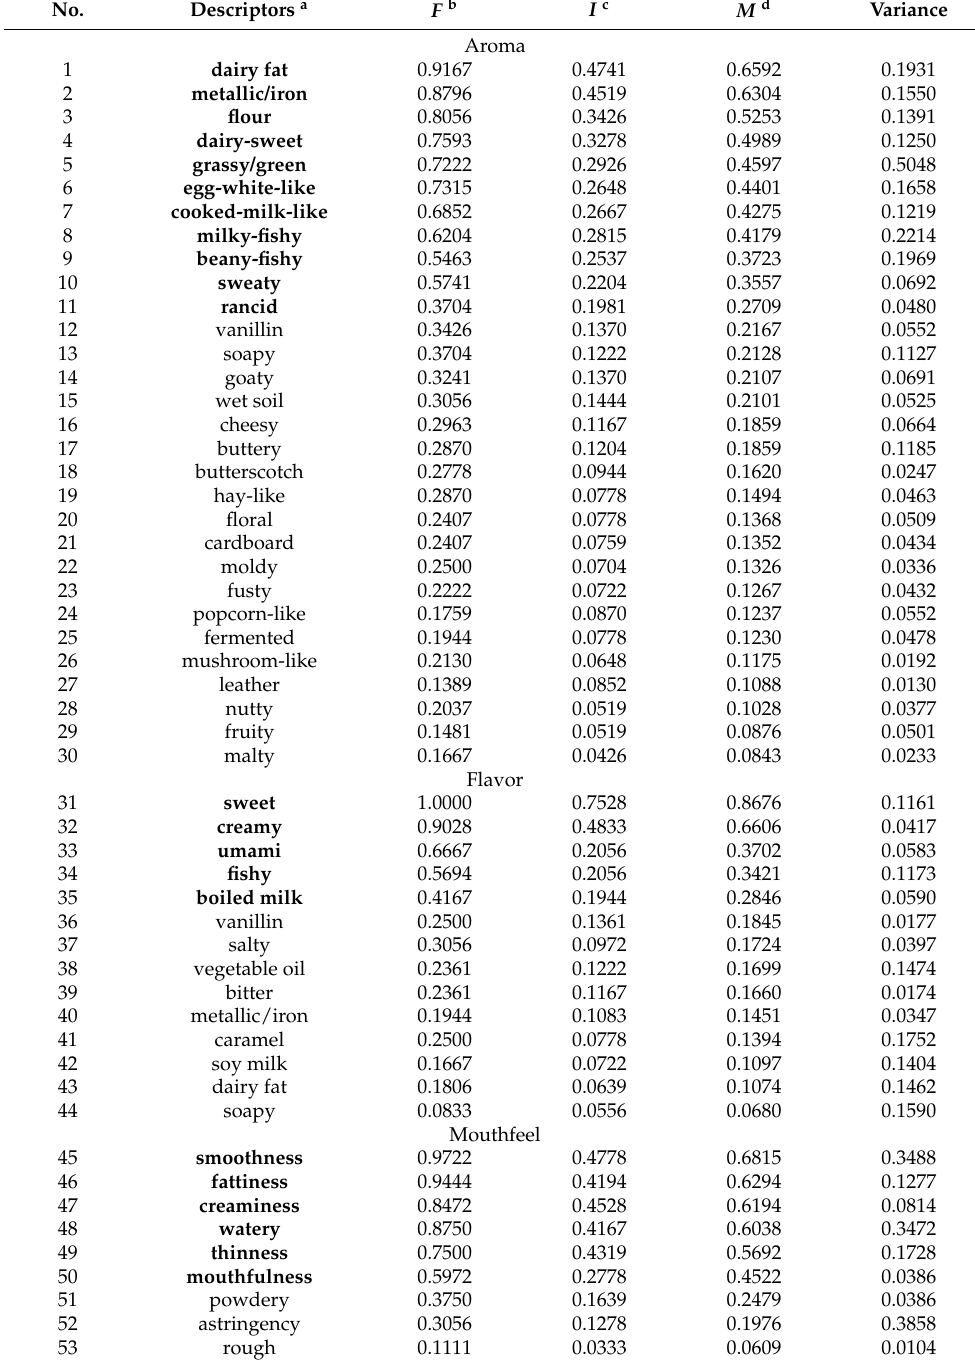
Table 2. Geometric mean M and variance of sensory descriptors of human